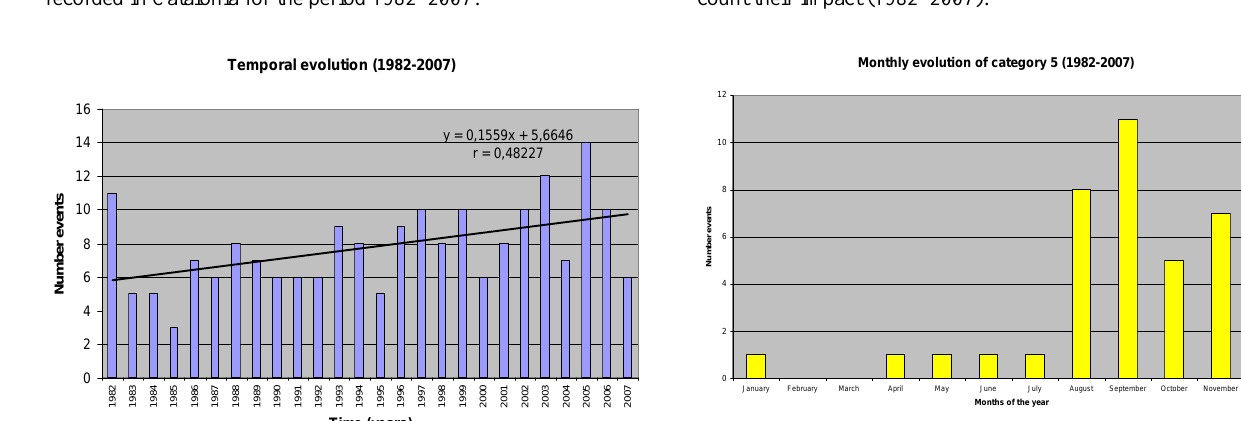
Fig. 6. Temporal evolution of flood events in Catalonia for the pe- Figure 6. Temporal evolution of flood events in Catalonia for the period 1982- riod 1982–2007. 2007